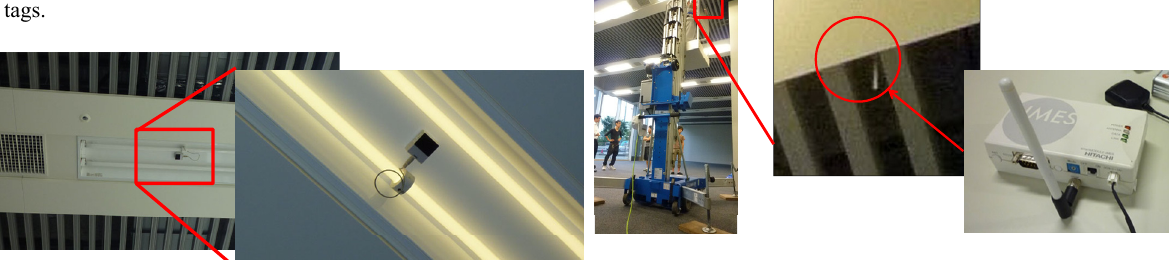
Figure 9. IMES transmitter installed on the